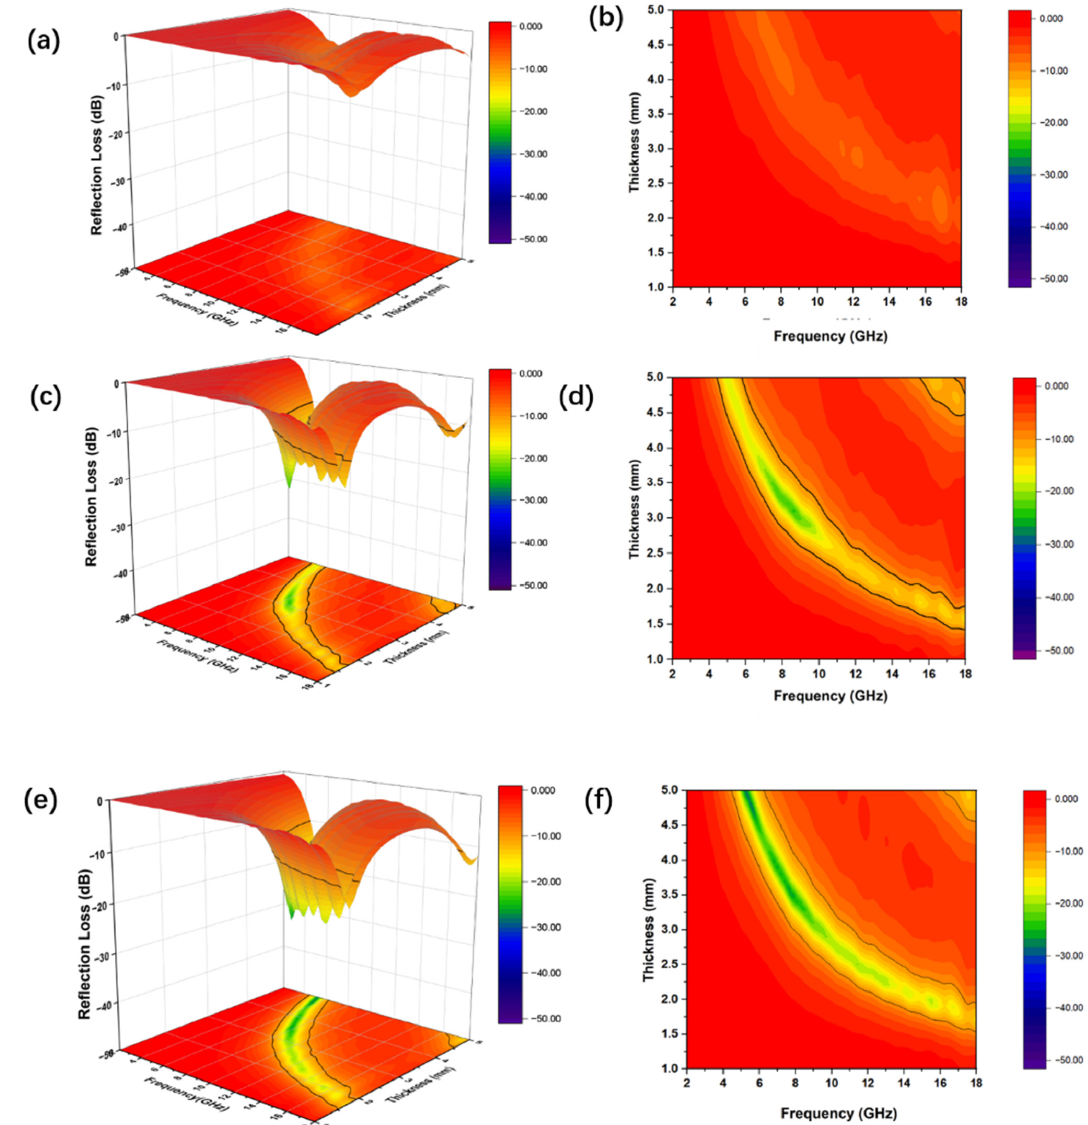
Figure 6. Reflection loss values in the frequency of 2–18 GHz for ( a , b ) MnO-Co@C-0.2; ( c , d ) MnO- Co@C-0.3; ( e , f ) Co@C-0.3; ( e , f ) MnO-Co@C-0.4.